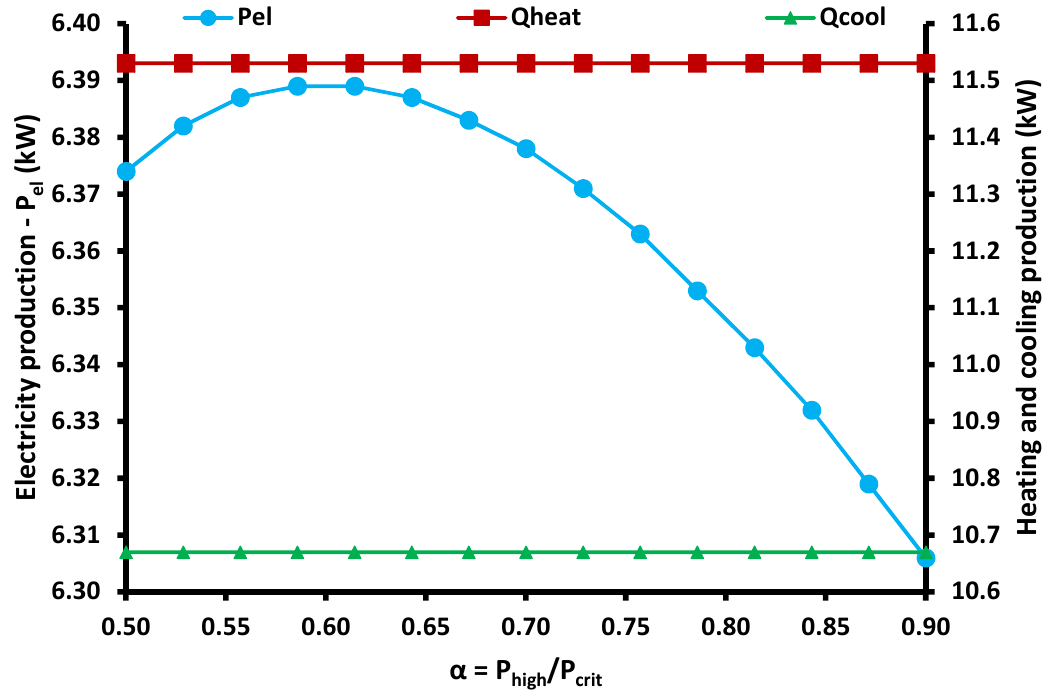
Figure 2. Electricity, heating, and cooling for different pressure ratio parameters.